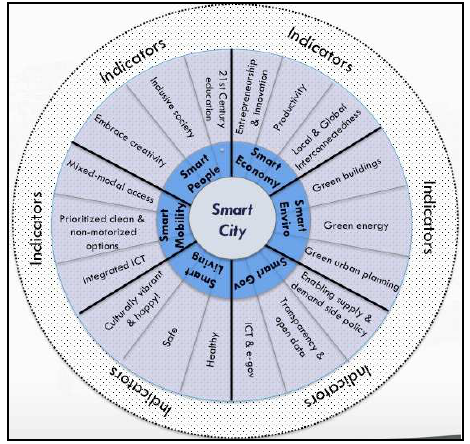
Fig. 1; Smart city wheel by Boyd